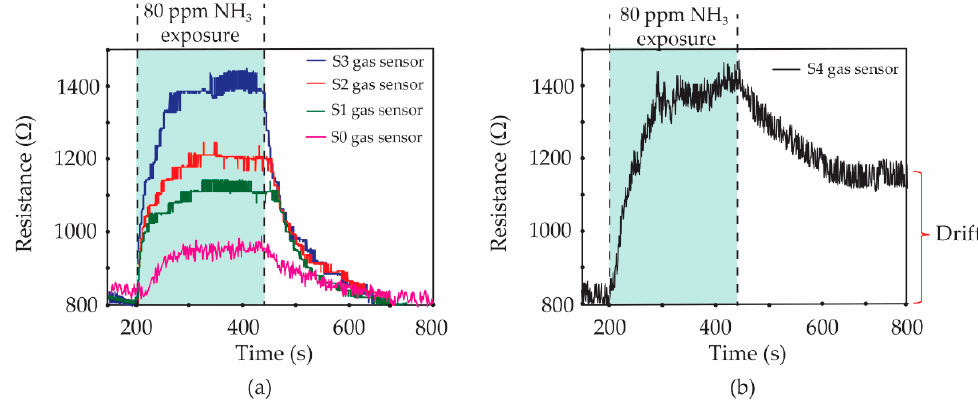
Figure 8. Resistance changes of ( a ) S0, S1, S2, S3 and ( b ) S4 gas sensors under 80 ppm NH 3 exposure.